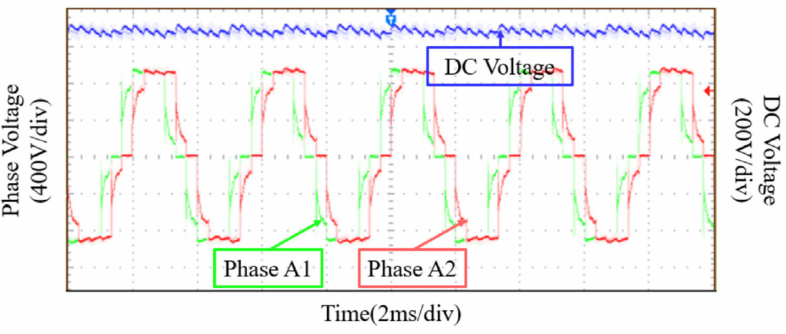
Figure 16. External characteristics validation.